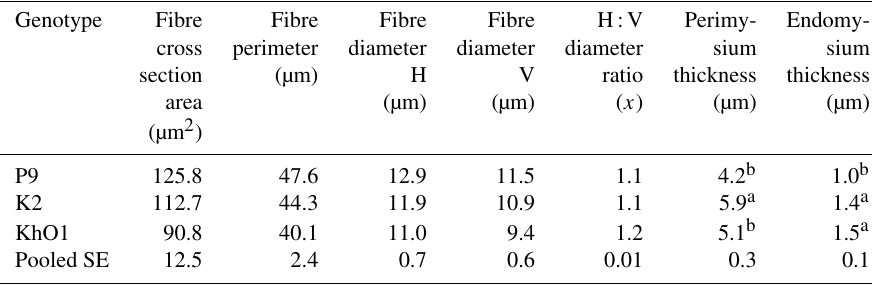
Table 5. Microstructural characteristics of m. pectoralis superficialis in spent ducks.